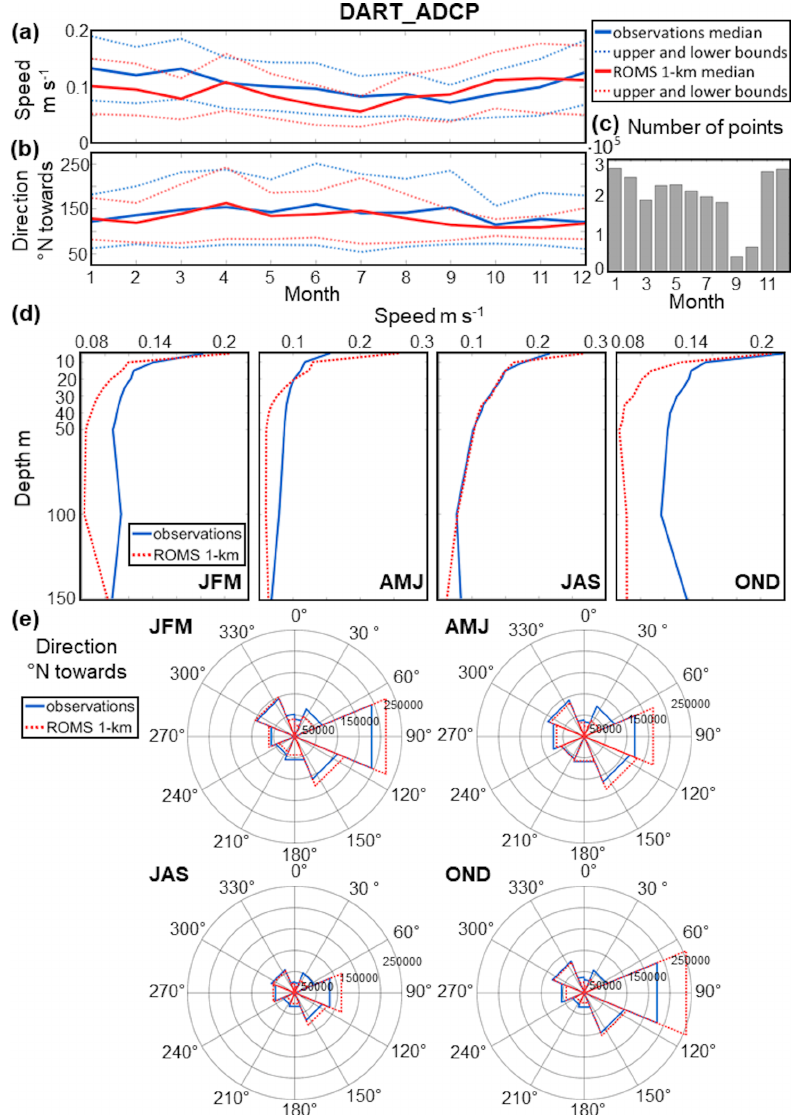
Figure 12. DART_ADCP dataset. Monthly climatology of AdriSC 1km and in situ (a) median speed, (b) median direction, and their variabilities (i.e. upper and lower bounds defined as ± MAD) as well as (c) the number of observations per month. Seasonal variations of the (d) speed of the AdriSC ROMS 1km model and observations depending on the depth. Seasonal rose plots of the (e) direction for ADCP observations and the AdriSC ROMS 1km